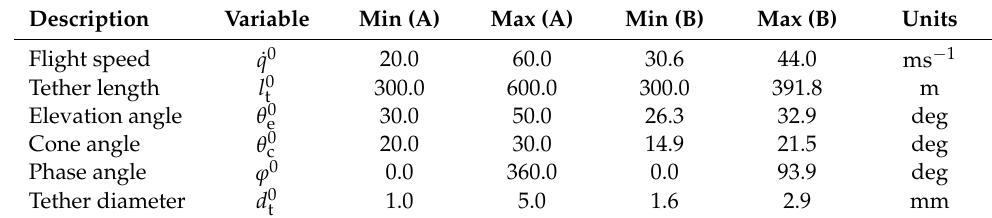
Table 3. Initialization parameter bounds used for uniform sampling by users A and B.